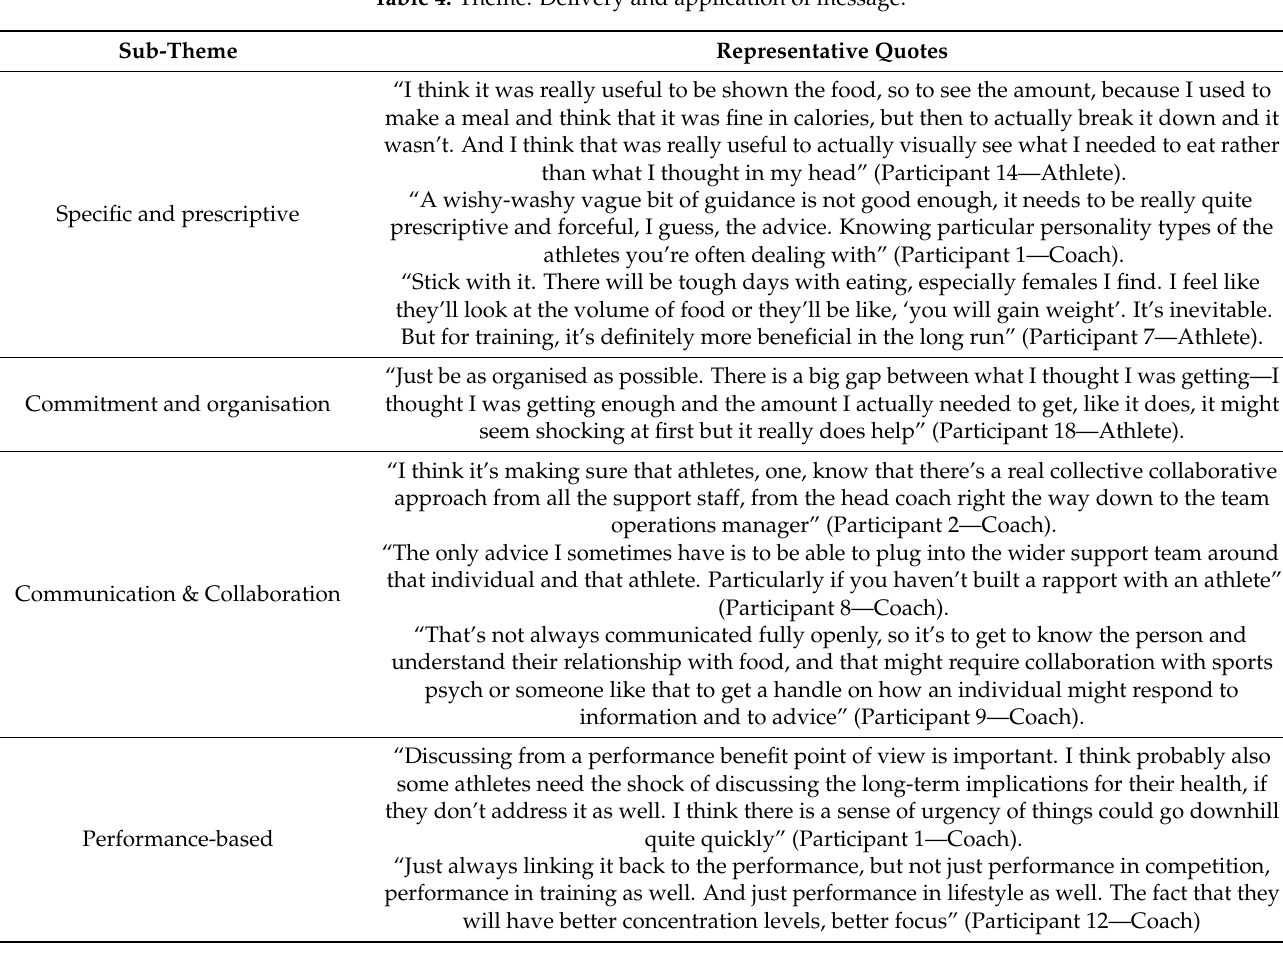
Table 4. Theme: Delivery and application of